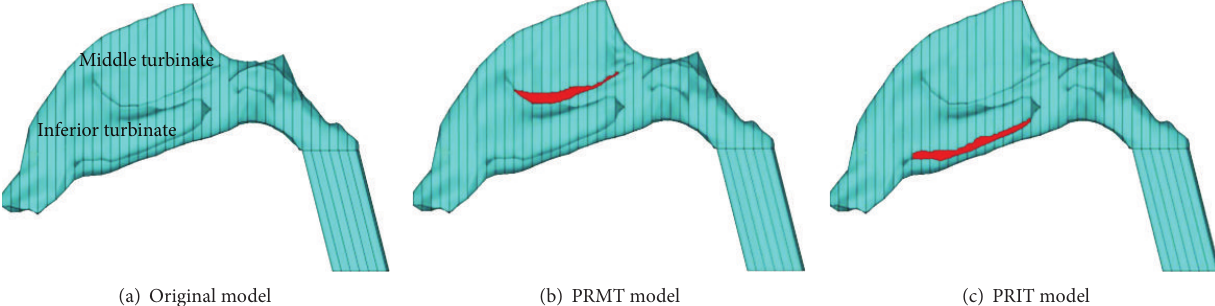
Figure 1: The selected nasal model (a) and the two variants ((b), (c)). Model (a) is the nasal model. Model (b) is the variant model with partial middle turbinate-removed (PRMT). Model (c) is the variant model with partial inferior turbinate-removed (PRIT). The red area shows the part which was removed.